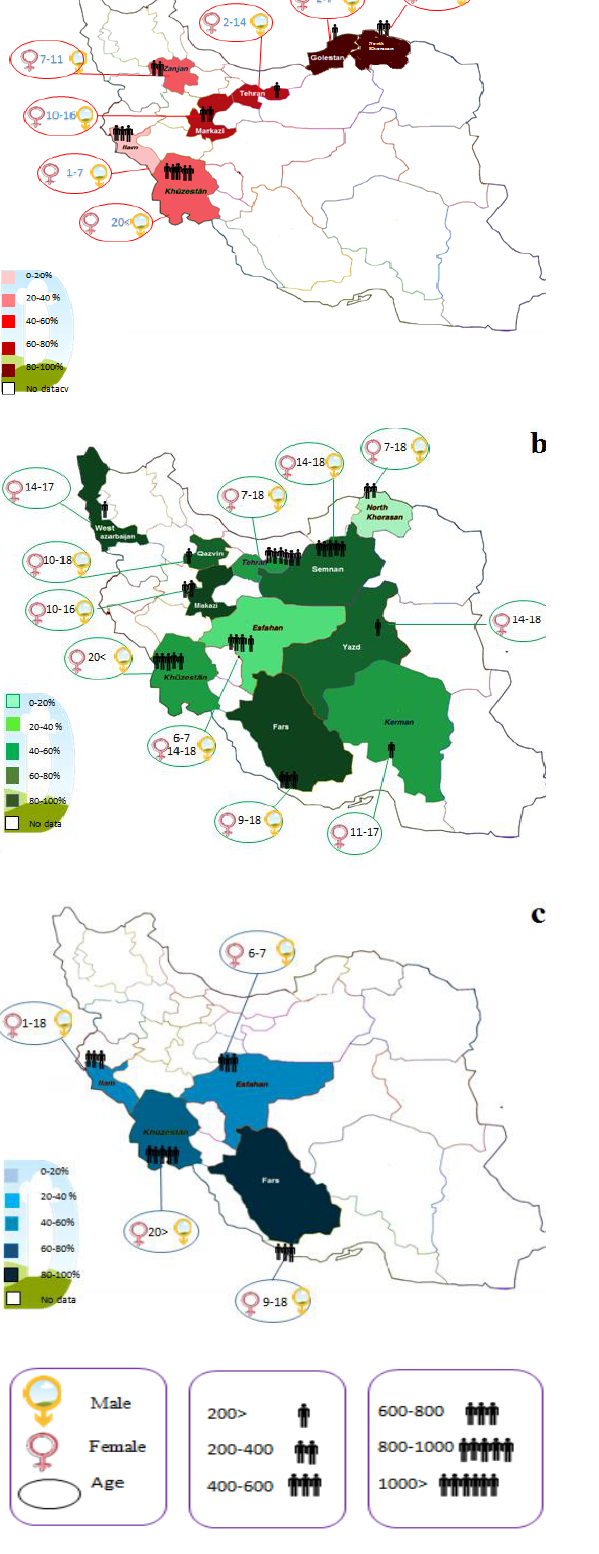
Figure 5. The prevalence of vitamin D deficiency in Iranian adults using cut-off values of 12 and 20 ng/ml, and prevalence of 25-(OH)-D levels <30 ng/ml (a, b, c,